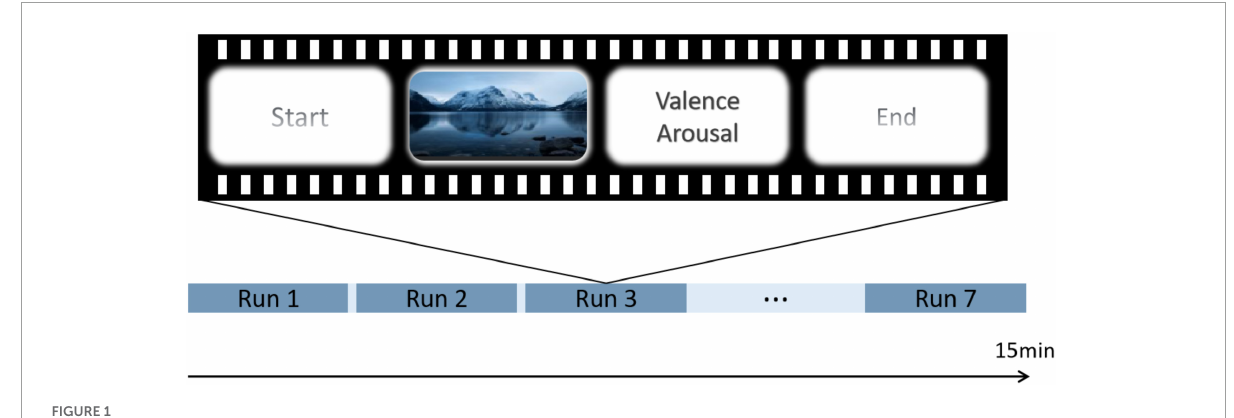
FIGURE1 Example of the experimental process